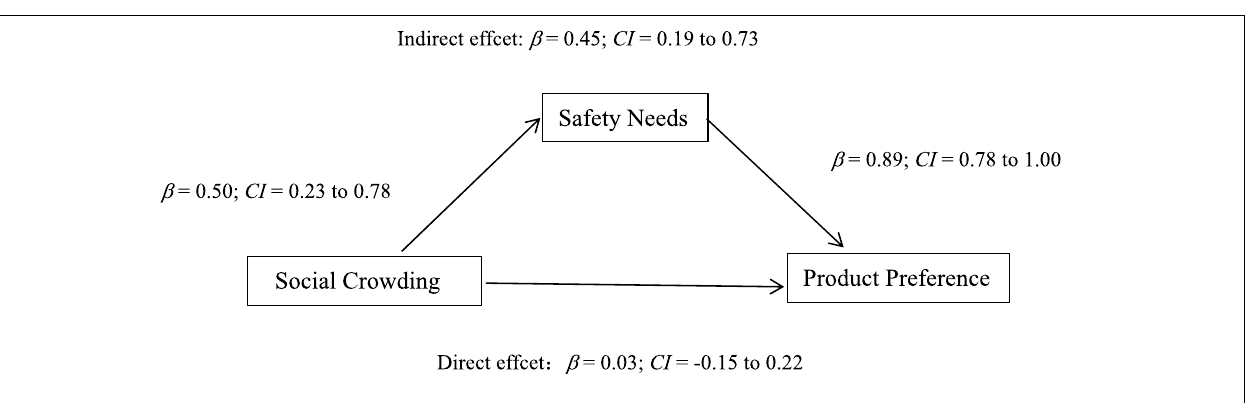
FIGURE 4 | The mediating effect of safety